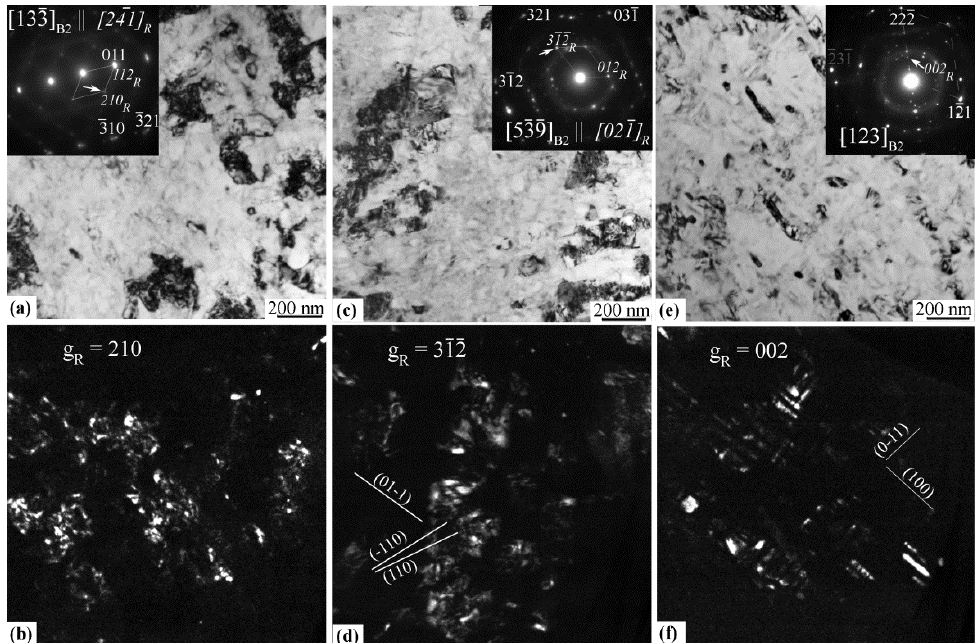
Figure 5. R phase morphology after annealing at 300 °C ( а , b ), 400 °C ( c , d ), and 450 °C ( e , f ). BF, SAED (Ds = 670 nm), and DF taken in the reflex of R phase indicated by the arrow on SAED. R-phase reciprocal lattice sections are highlighted by lines on SAEDs, and traces of planes corresponding to the habitus planes of the R phase are marked on the DFs.